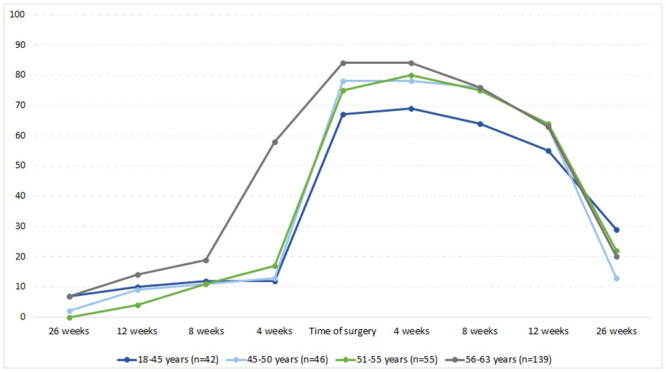
The proportion of patients being on sick leave at different time points, divided into age groups.The figure illustrates the status of the patients (on sick leave) at different time points before and after surgery, divided into age groups.